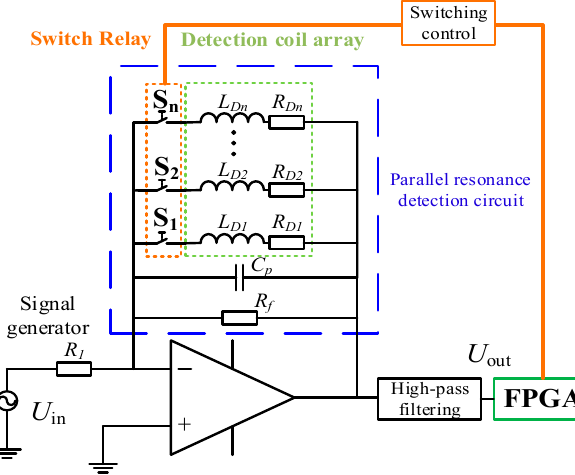
Figure 14. The structure of FOD system.